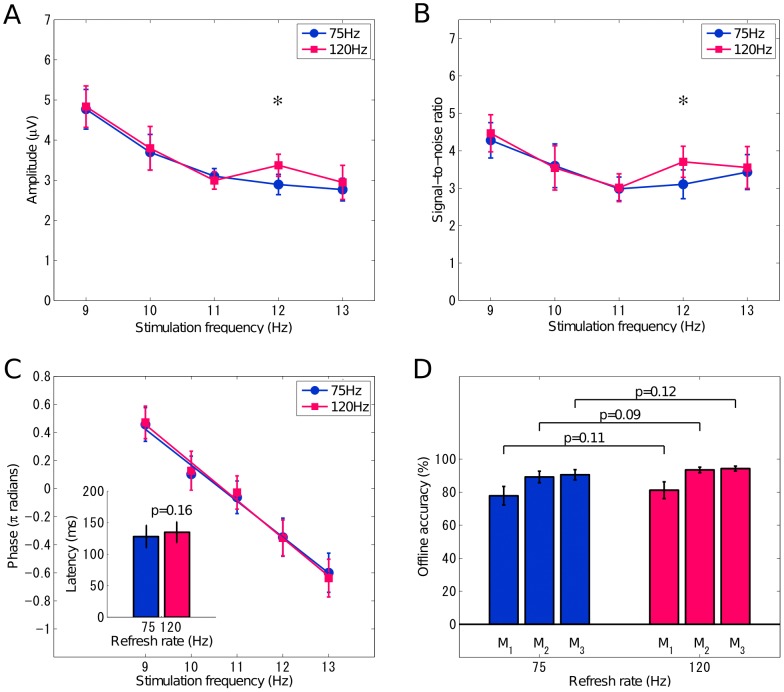
Signal characteristics and offline classification accuracy comparison between 75 Hz and 120 Hz refresh rates.Averaged (A) amplitudes (B) SNRs of elicited SSVEPs at each stimulus frequency across all subjects, (C) averaged phases in π radians, and latencies across subjects, and (D) averaged classification accuracy across subjects under 75 Hz and 120 Hz refresh rates using FFT-based method (M1) and CCA-based methods (M2: with the fundamental harmonic in the reference signals; M3: with the fundamental and second harmonics in the reference signals). Error bars indicate standard errors. The asterisk indicates a significant difference between 75 Hz and 120 Hz (p<0.001).